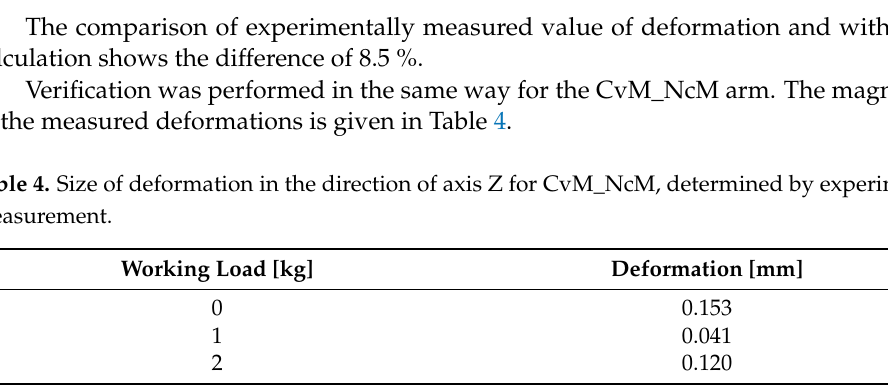
Figure 11. Size of deformation in the direction of axis Z for AdM_NcM, determined by the experimental measurement with the load of 1 kg.